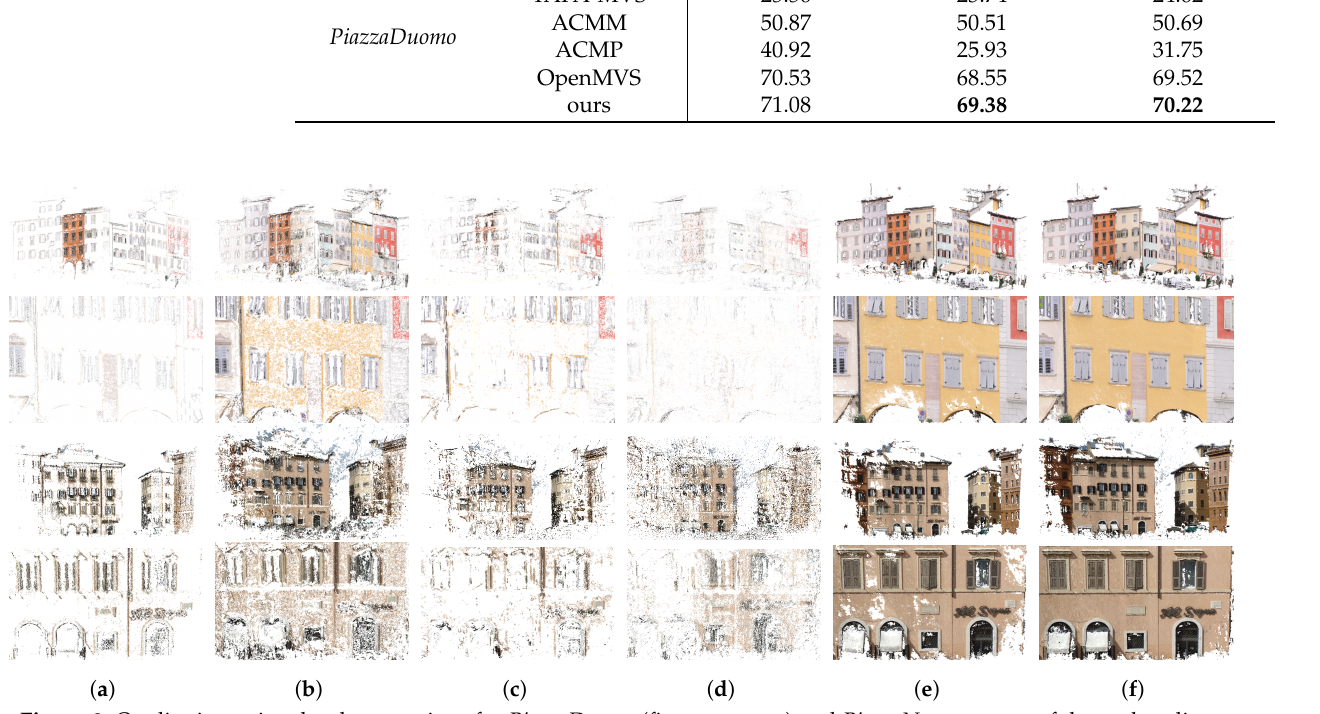
Figure 8. Qualitative point cloud comparison for PiazzaDuomo (first two rows) and PiazzaNavona : state of the art baselines results versus the proposed method (last column). ( a ) COLMAP; ( b ) ACMM; ( c ) ACMP; ( d ) TAPA-MVS; ( e ) OpenMVS; ( f ) proposed.